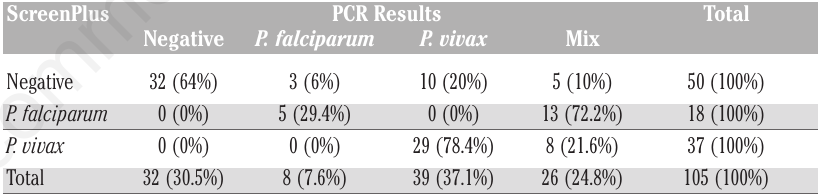
Table 8. Comparison of species detection between ScreenPlus and RT-PCR.